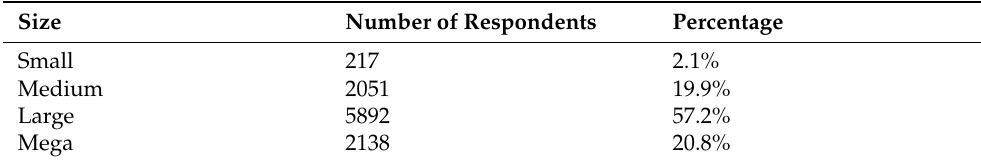
Table 2. Distribution of participants by university size.